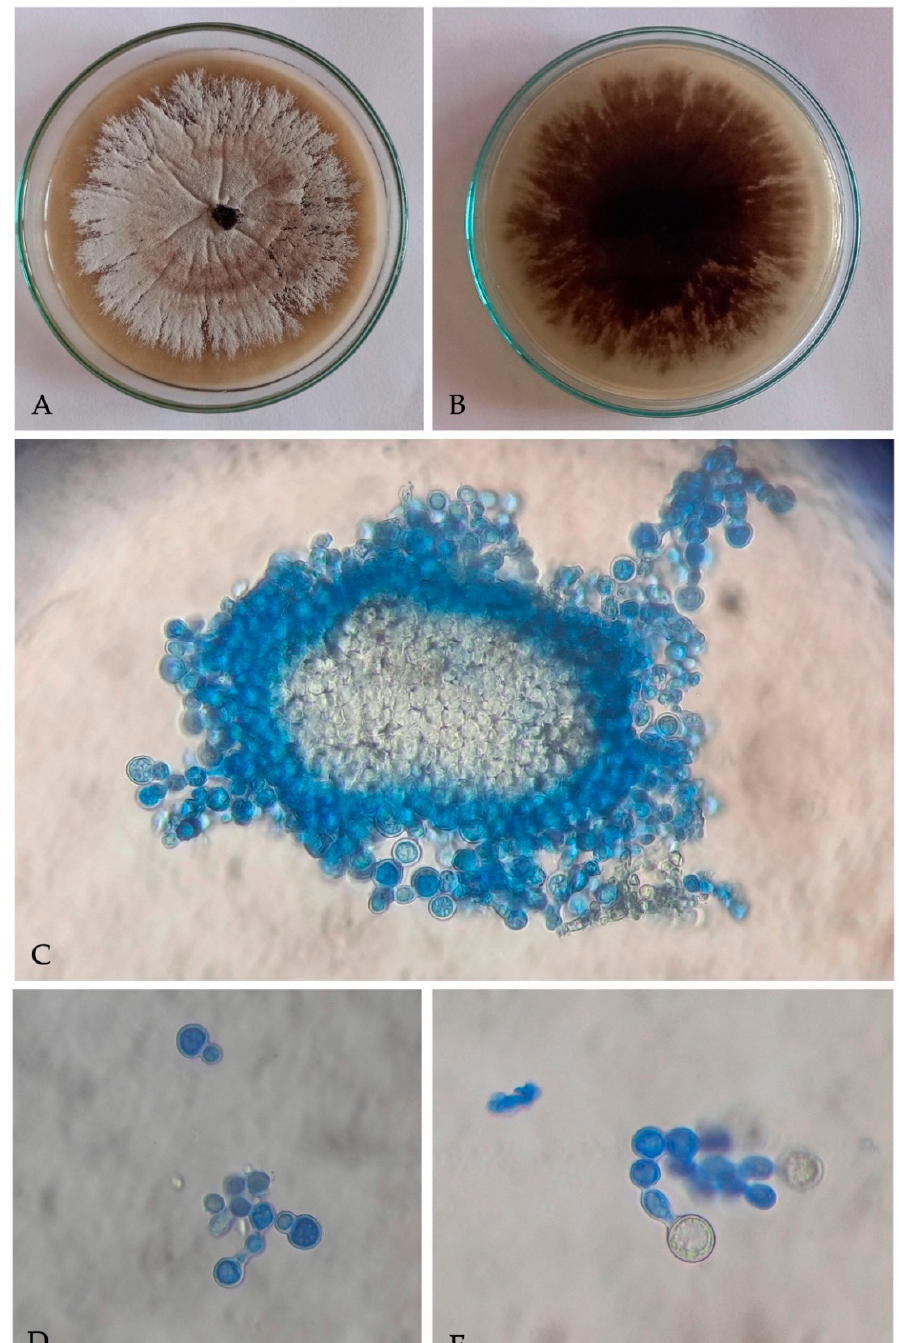
Figure 2. Culture of Ambrosiella roeperi : ( A ) upper surface of culture plate; ( B ) under surface of cul- ture plate; ( C ) sporodochial mass isolated from mycangia; ( D ) branched conidiophores with terminal aleurioconidia; ( E ) developing aleurioconidia on swollen conidiophore cells.